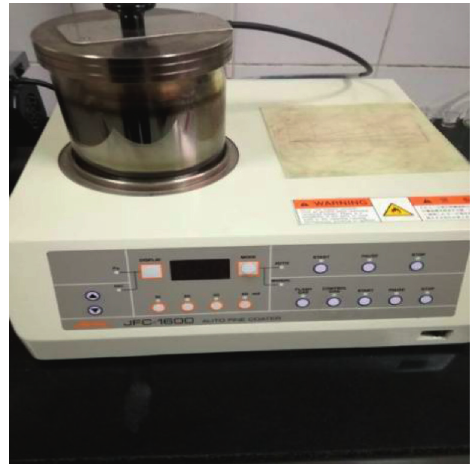
Figure 13: Automatic carbon coating instrument.